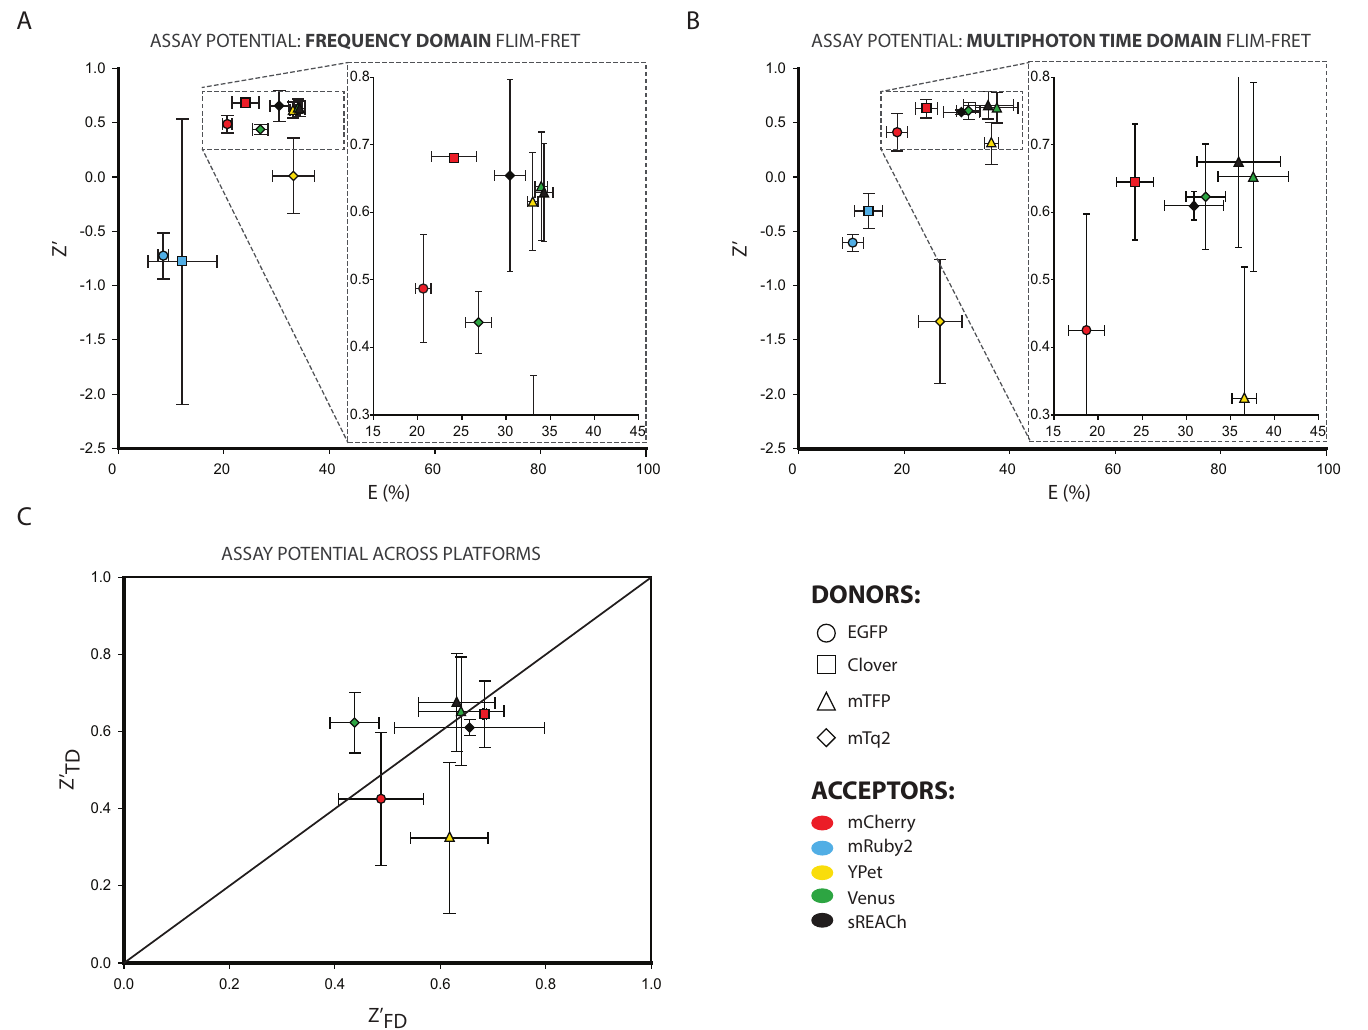
Fig 4. Z-Factor and FRET efficiency as a measure of the single time point assay potential of FRET pairs expressed in mammalian cells. Throughout this figure the donor involved is denoted by the shape of the point (EGFP = circle, Clv = square, mTFP = triangle and mTq2 = diamond) and the acceptor is denoted by the fill-colour of the symbol (mCh = red, mR2 = blue, YPet = yellow, Ven = green and sRCh = black) A. Plot of the mean Z’ of the frequency domain lifetime measurements in 3 separate experiments against their mean FRET Efficiency for those experiments. Error bars on both axes represent standard deviation. B. Plot of the mean Z’ of the multiphoton time domain lifetime measurements in 3 separate experiments against their mean FRET Efficiency for those experiments. Error bars on both axes represent standard deviation. C. Direct comparison of the Z’ values from the two different FLIM systems; pairs that respond similarly on both systems will fall on the x = y diagonal. Error bars represent standard